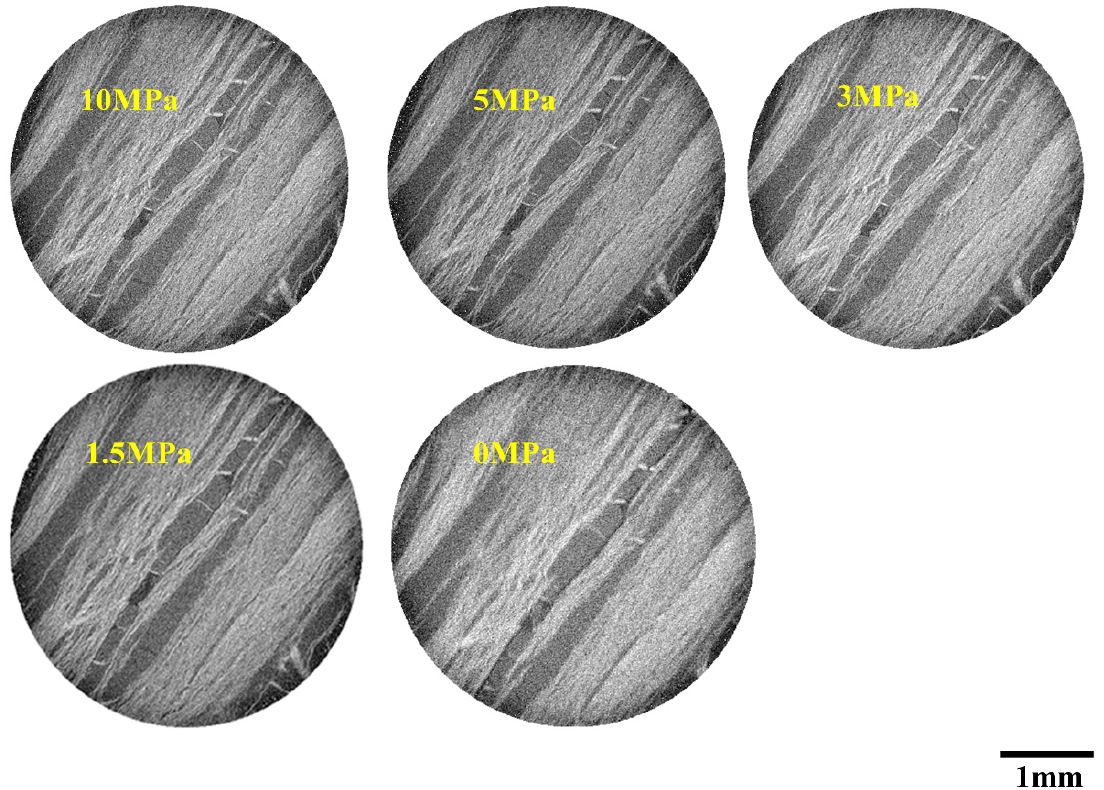
Figure 8. The 2D images of the same position in the second cycle (with the decrease in confining pressure).